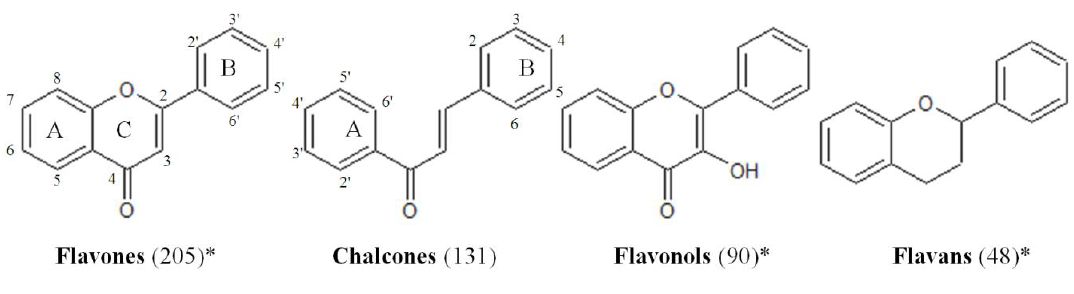
Figure 1. The most important flavonoid classes represented in the flavonoids chemical library. The amount of compounds per class present in the library is indicated between parentheses. Flavanones, isoflavonoids, neoflavonoids and dihydroflavonols